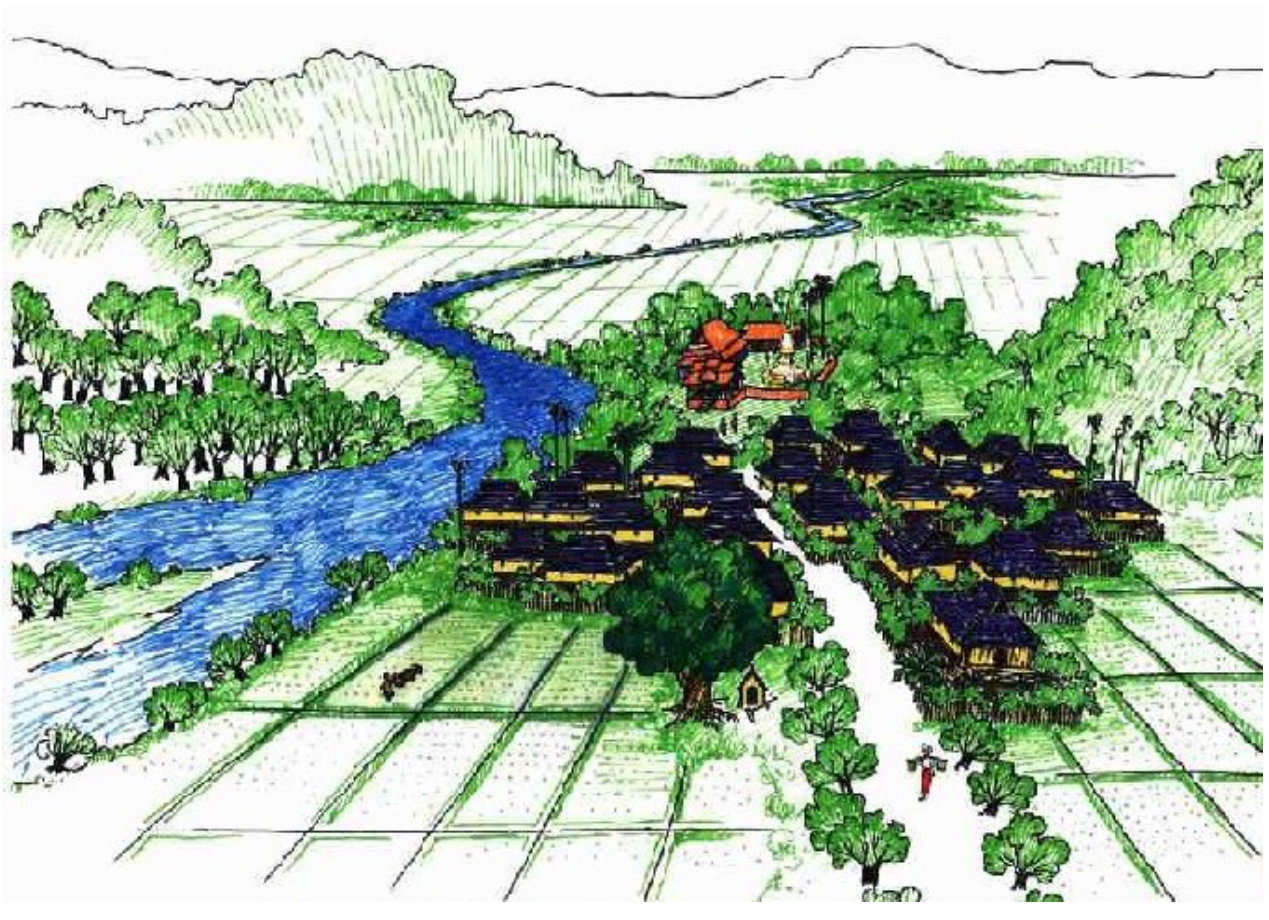
Fig. 2. A landscape of a lowland Dai village in Xishuangbanna. The drawing shows a fuelwood forest of Cassia siamea trees on the left, a sacred forest or “holy hill” on the right, a temple yard garden in the background, and a home garden with residential areas and paddy fields in the foreground. Illustration by Yang Jiankun, Kunming Institute of Botany, Kunming,